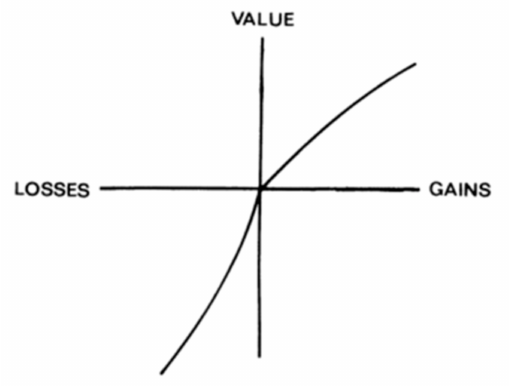
Figure 2. S-shaped value function, proposed by the Prospect theory